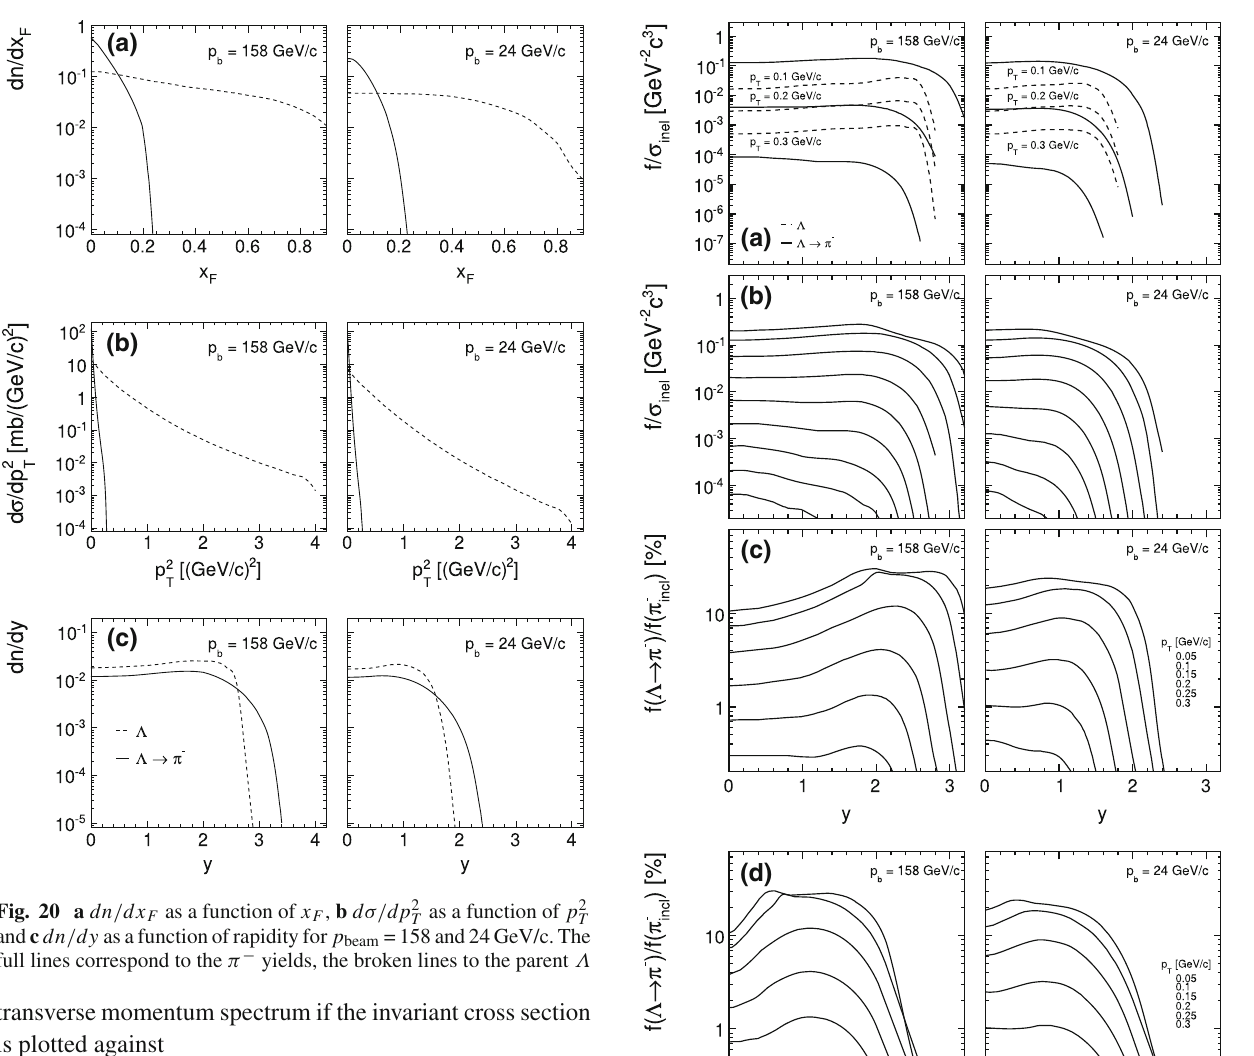
as a function of p 2 T T